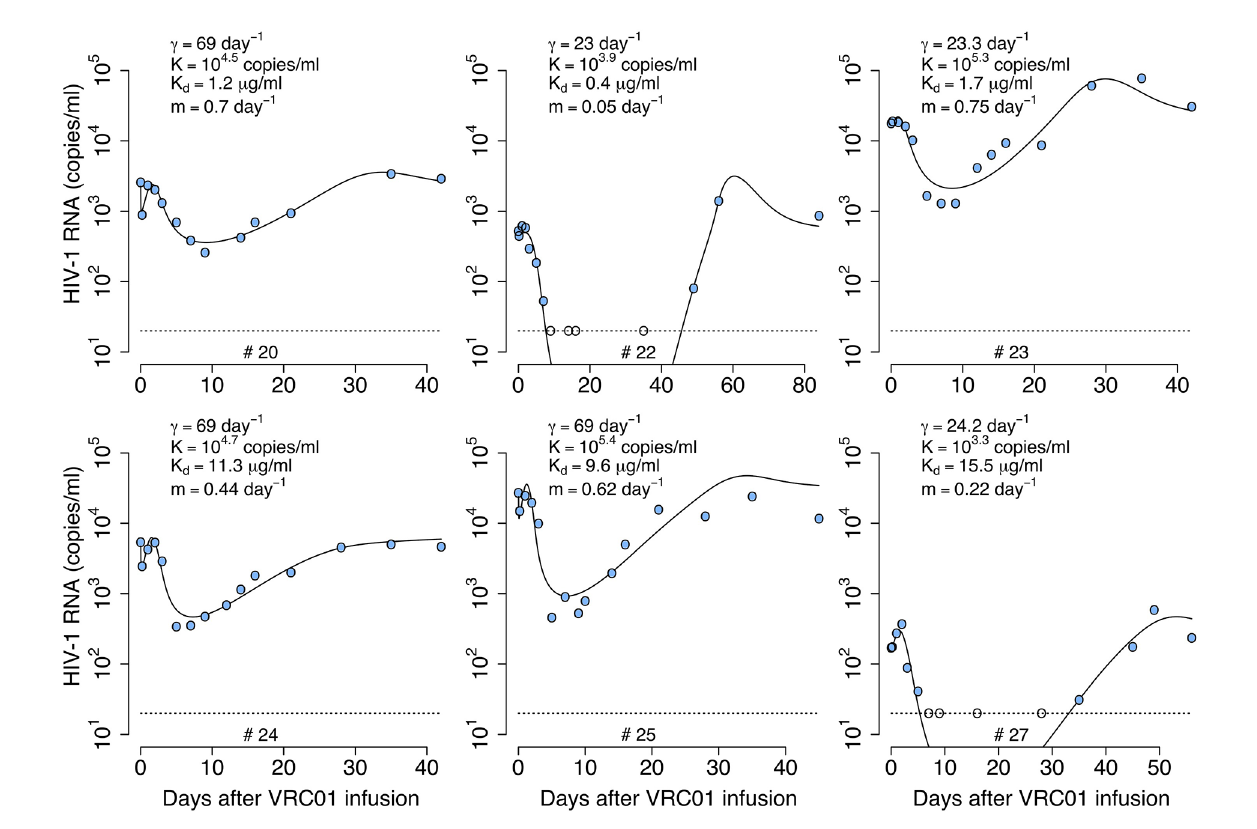
FIGURE 9 | Best- fi ts of the phagocytosis-based logistic clearance model (PLCM), equation (19), to viral load data from participants receiving a single infusion of VRC01. Blue- fi lled and un fi lled circles are the HIV-RNA over and below the limit of detection, respectively. Solid black lines are of best fi t of the model, ( V + C ) in equation (19), to the data. Relevant parameter estimates for each participant are shown in each plot. Fixed parameter values are described in Table 1 . See all parameter estimates in Table S6 . Other parameters and initial values were derived by assuming the system was in steady state before VRC01